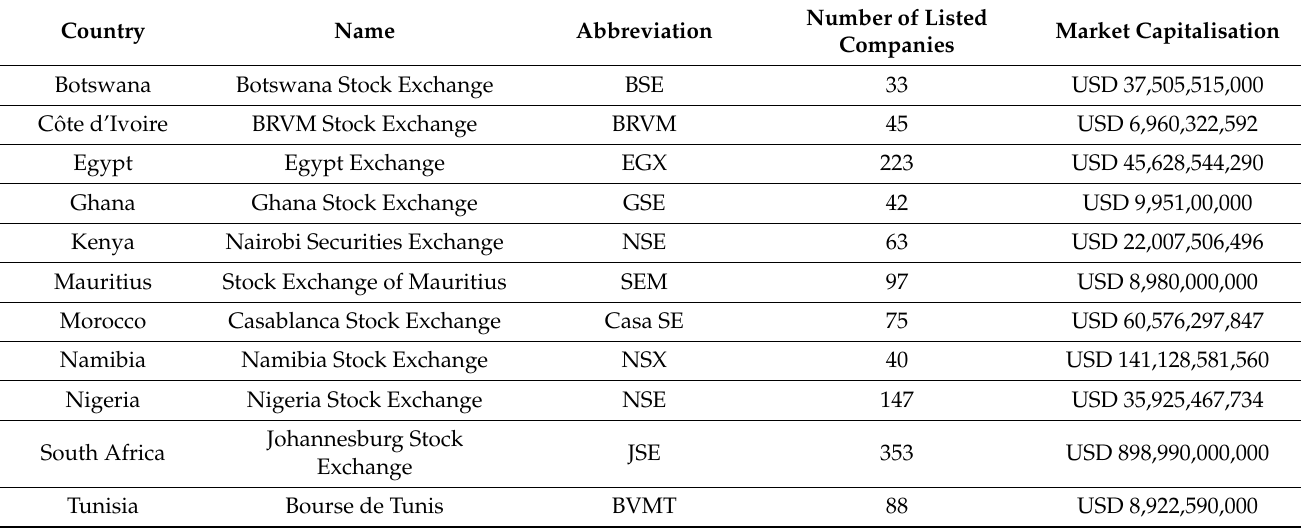
Table 2. Selected African stock